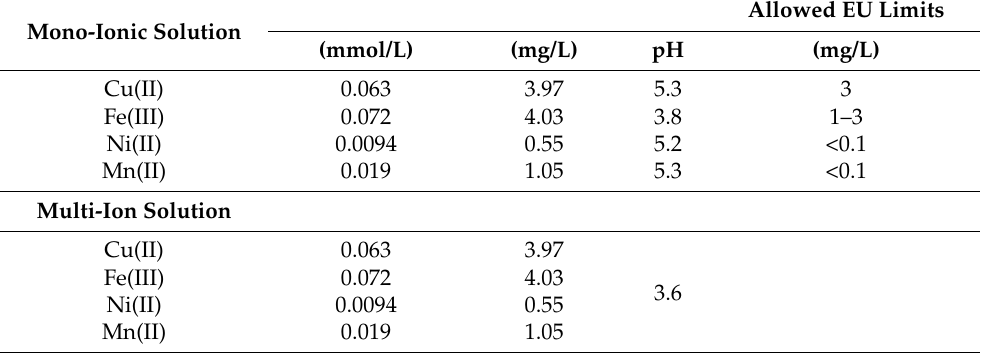
Table 3. Synthetic solutions composition and EU emission limits [1,2].